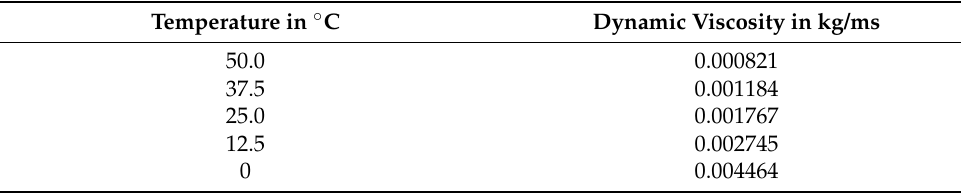
Table A1. Temperature dependent on the dynamic viscosity of the electrolyte.